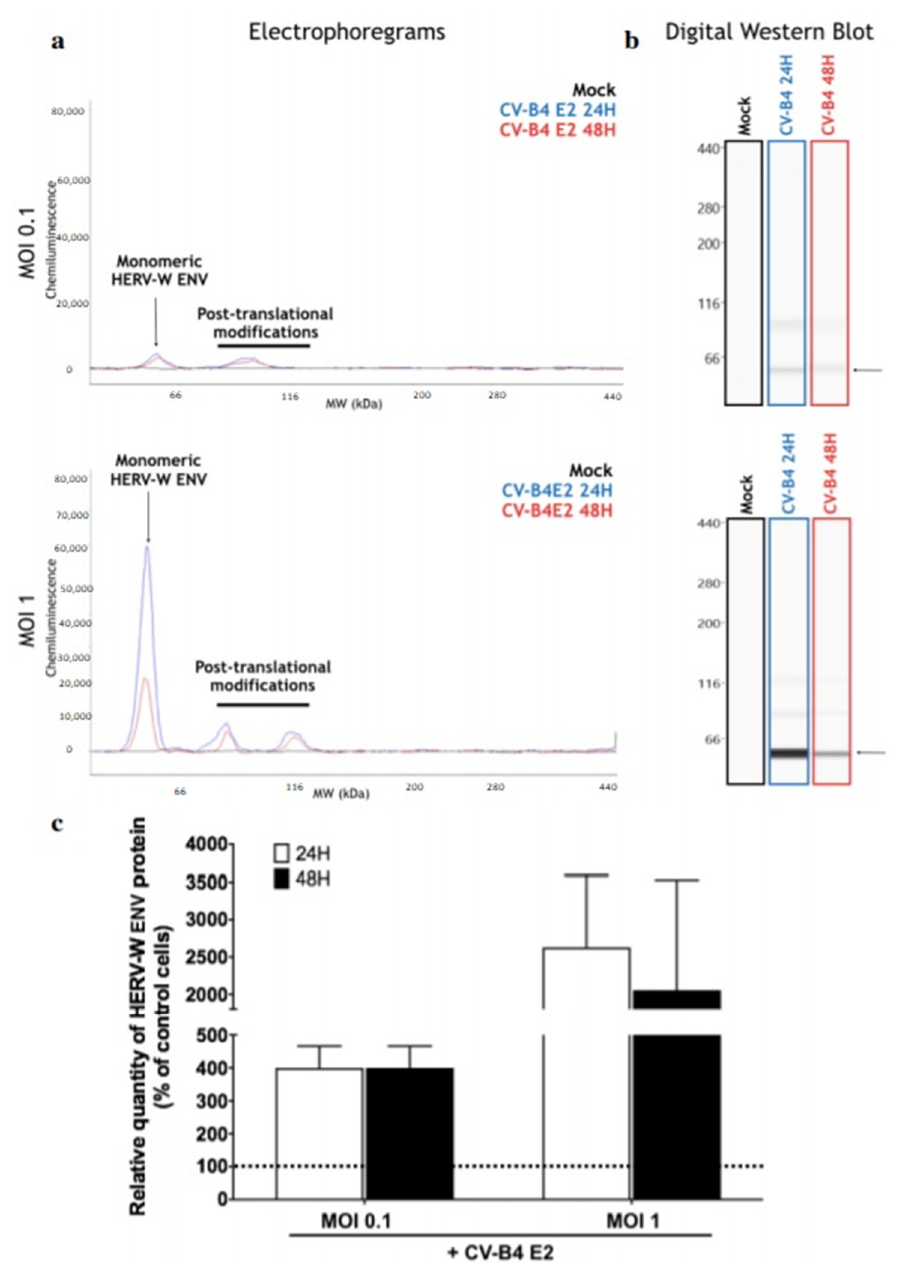
Figure 3. Levels of Human Endogenous Retrovirus W Envelope (HERV-W ENV) protein in primary pancreatic ductal cells infected by Coxsackievirus B4 (CV-B4). The levels of intracellular HERV-ENV protein in ductal cells obtained from two brain-dead donors were evaluated using capillary automated Western blot (Simple Western technology, ProteinSimple ® ). The cultures were inoculated with CV-B4 E2 at multiplicity of infection 0.1 and 1. Total protein lysates were analyzed on a 66-440kDa separation matrix, and HERV-W Env was detected using GN_mAb_Env01 antibody. ( a ) Electrophoregrams provided the migration profile of the target, and the intensity of the specific signal was precisely quantified using the area under curve (AUC) determination. ( b ) Signal quantification of the main peak corresponding to the monomeric form of HERV-W Env not carrying post-translational modifications (black arrow) was presented in a digital Western blot. ( c ) Results are expressed as the relative quantity of ENV in infected cultures compared with the non-specific background signal in mock-infected cultures. Results are presented as the mean ± SD of two independent experiments. The dotted line indicates the non-specific background signal of mock-infected cultures.